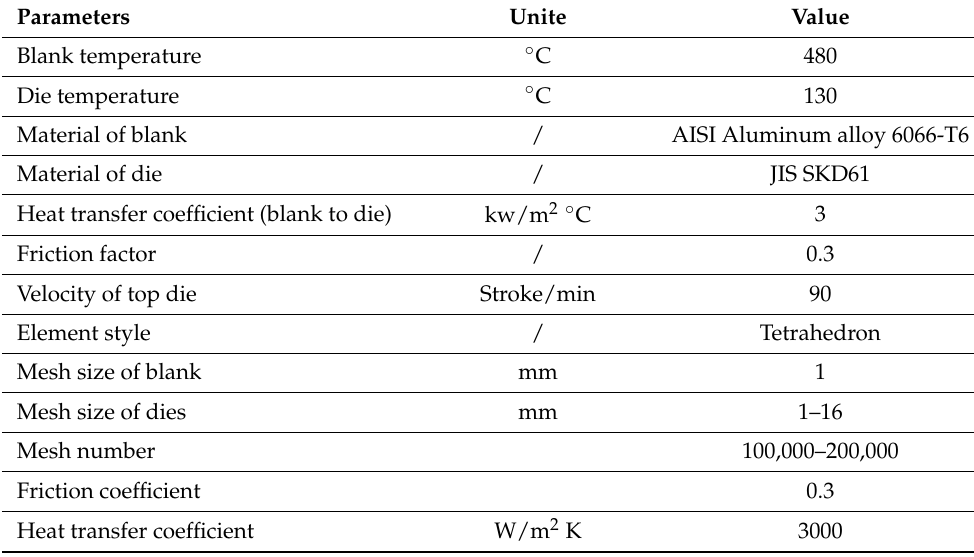
Table 3. The parameters of the forging process of the crown forgings.